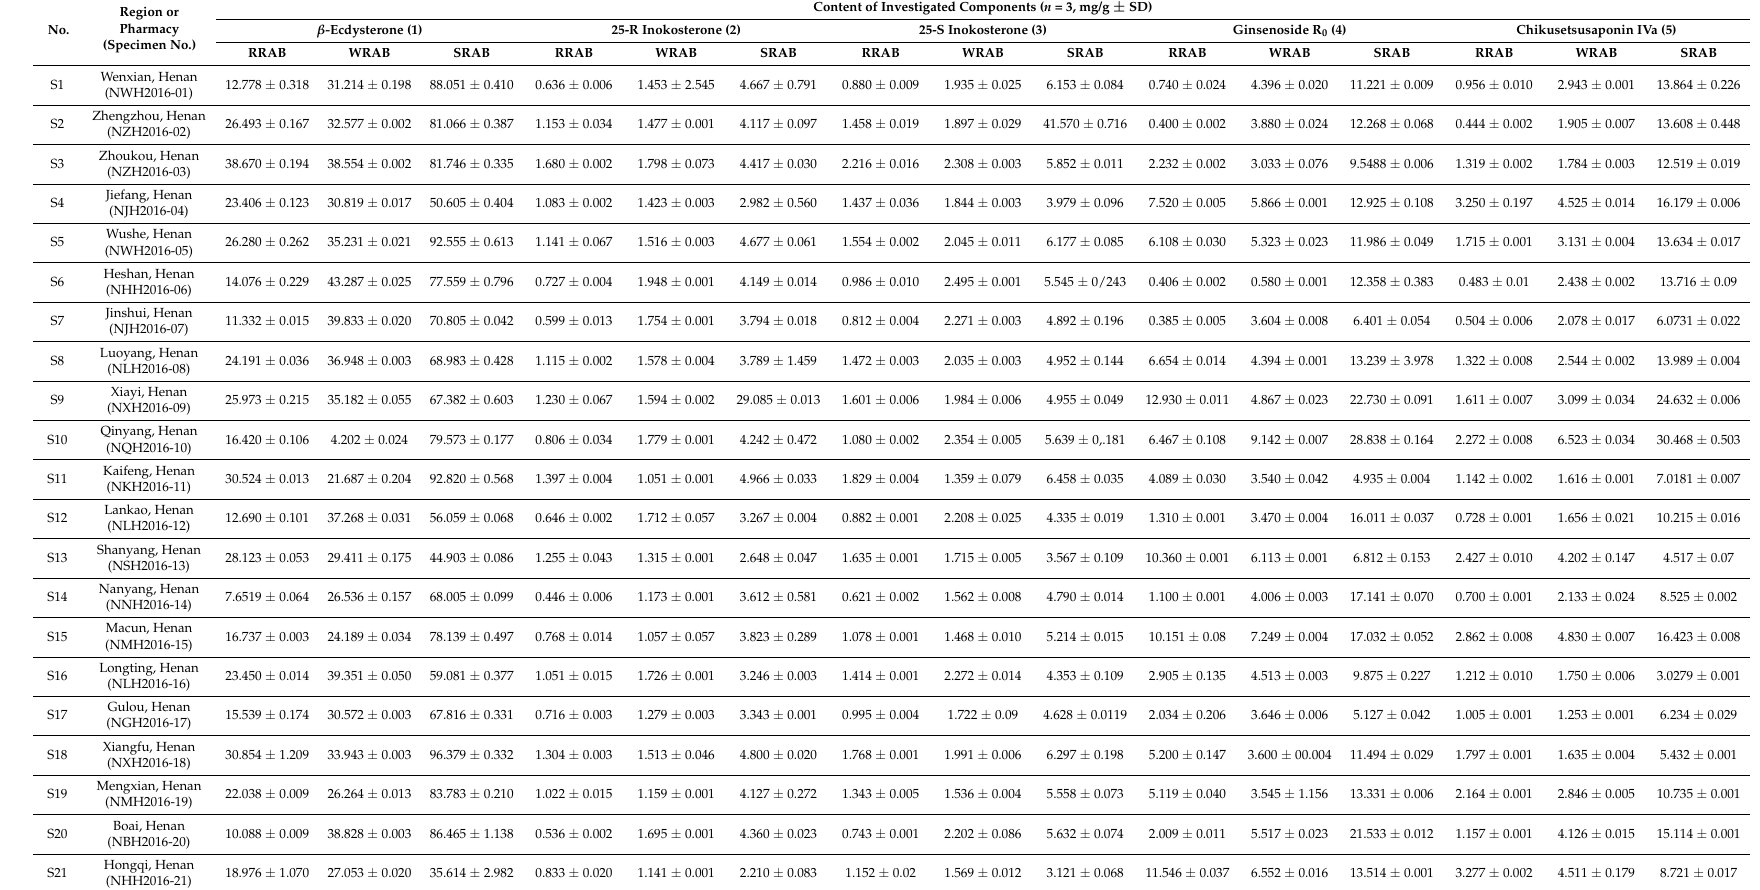
Table 4. Contents of five analytes in 21 batches of raw, wine-processed, and salt-processed